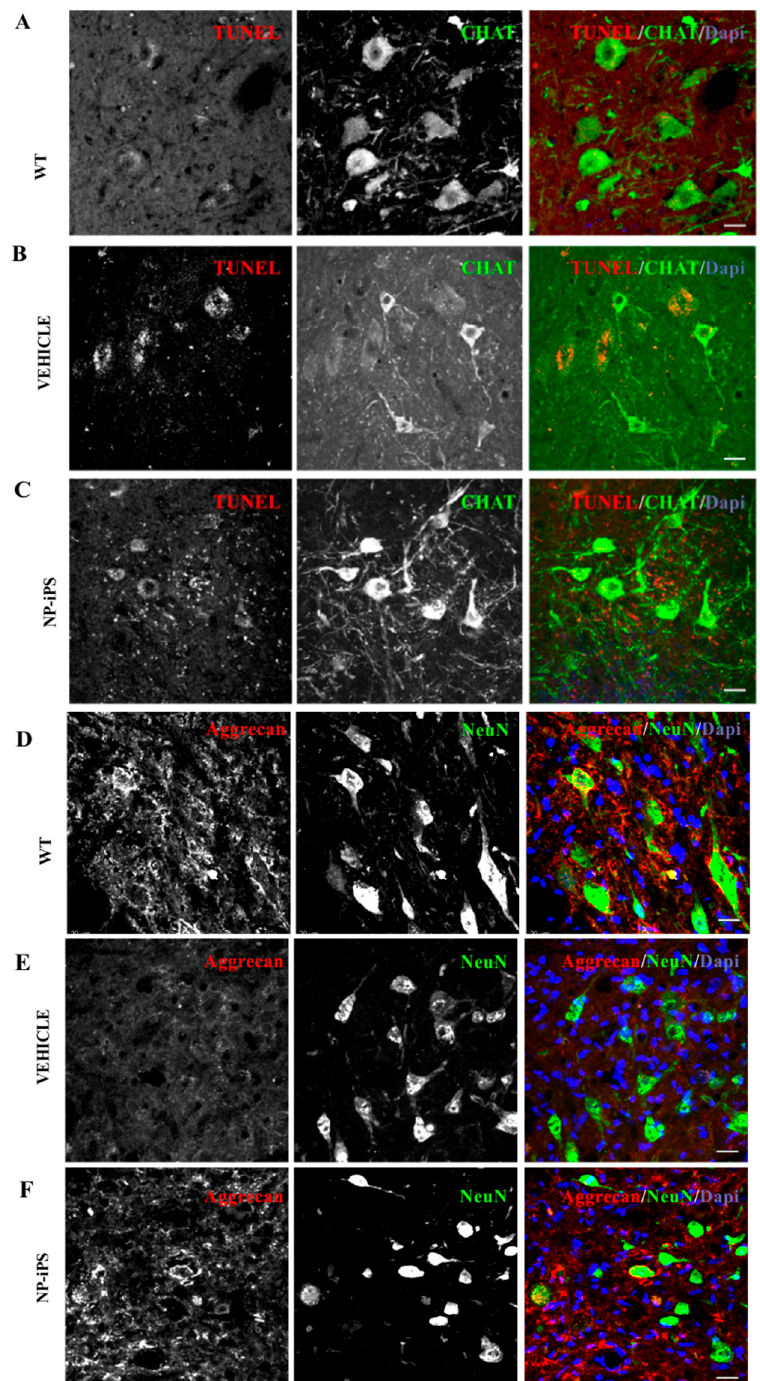
Figure 5. Transplantation of NP-iPS preserved spinal perineuronal nets. Co-localization of TUNEL and anti-CHAT staining confirmed MN apoptosis in vehicle-treated SOD1 rats ( B ), which was not seen in WT animals ( A ) and was faintly detected in NP-iPS treated animals ( C ). IHC staining demonstrates the normal perineuronal nets (PNN) structure revealed by anti-aggrecan antibody in the ventral horns of WT rats ( D ). NP-iPS-treated rats ( F ) had a similar expression of PNN to that observed in WT littermates ( D ), while vehicle-treated SOD1 Tg animals had mitigated PNN structure ( E ). IHC staining revealed the high power of preserved aggrecan protein in close vicinity to engrafted NP-iPS ( F ), while vehicle-treated Tg rats showed vestigial PNN ( E ). Cell nuclei were visualized with DAPI staining. Scale bars = 20 µm.